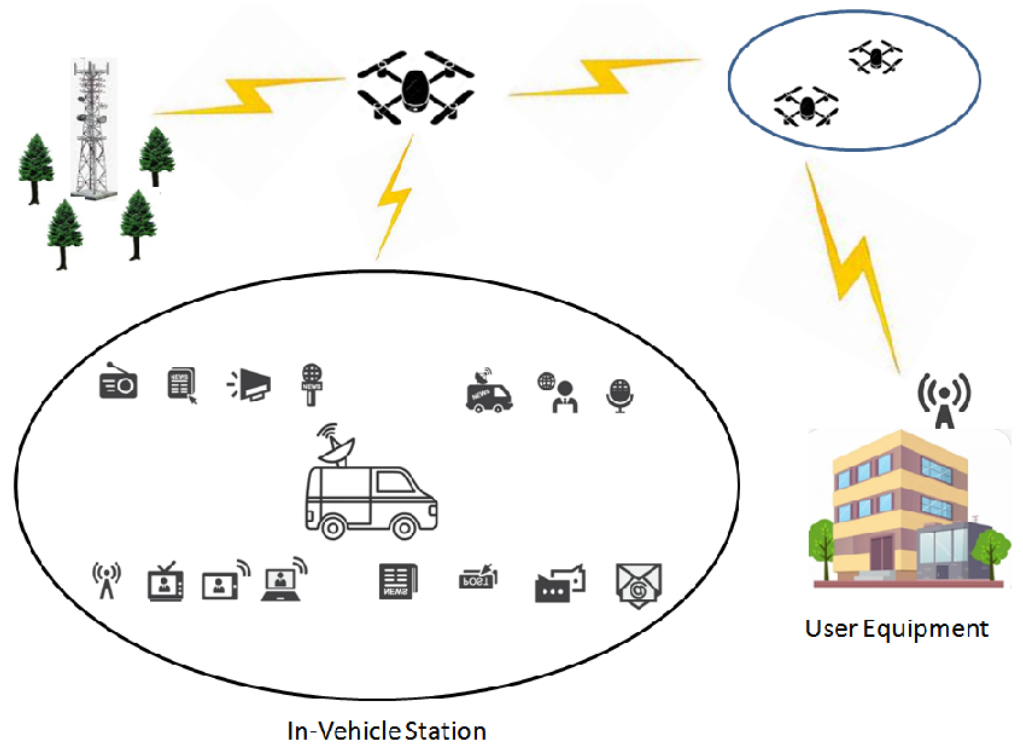
Figure 10. Multimedia application of